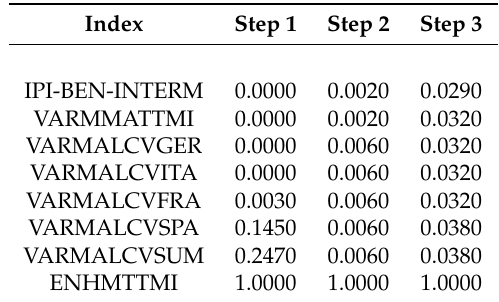
Table A25. Model confidence set hierarchy loss function is absolute error at the end of the sample for intermediate goods model comparison α = 0.05, number of bootstrap replications = 5000 and block length = 12. The null hypothesis is that the average performance of the model in the row is as small as the minimum average performance across the remaining models. The alternative is that the minimum average loss across the remaining models is smaller than the average performance of the model in the